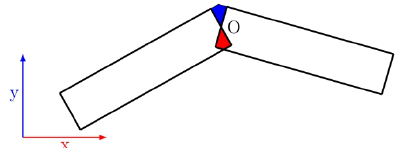
Figure 9. Overlap of the two non-straight deposi- tions (overlapping volume marked with red). The red volume must be redistributed into the green